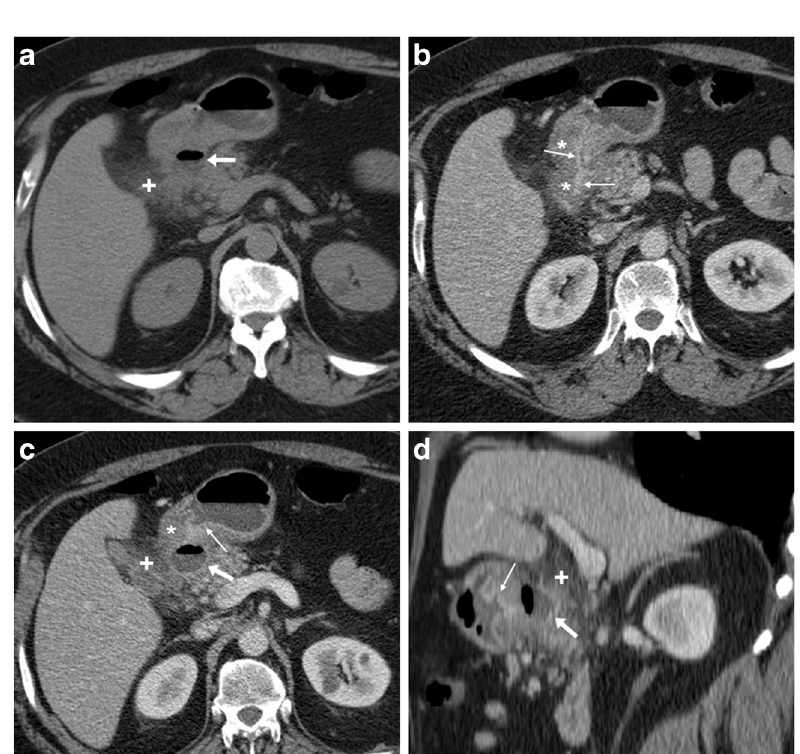
Fig. 3 A 55-year-old female with unremarkable medical history experienced severe abdominal pain with left-sided tenderness and minimally elevated serum lipase. Multiplanar CT images showed collapsed gastric antrum with moderately thickened, stratified wall (*) and enhancing mucosa (thin arrows). Additionally, inflammatory hyperattenuation of surrounding and infrahepatic fat planes (+) reinforced suspicion of acute PUD. The subtle, small-sized mucosal defect with centimetric outpouching (arrows in c , d ) corresponded to endoscopic finding (image in inset d ) of posterior prepyloric ulcer with oedematous margins and fibrinous crater. The patient